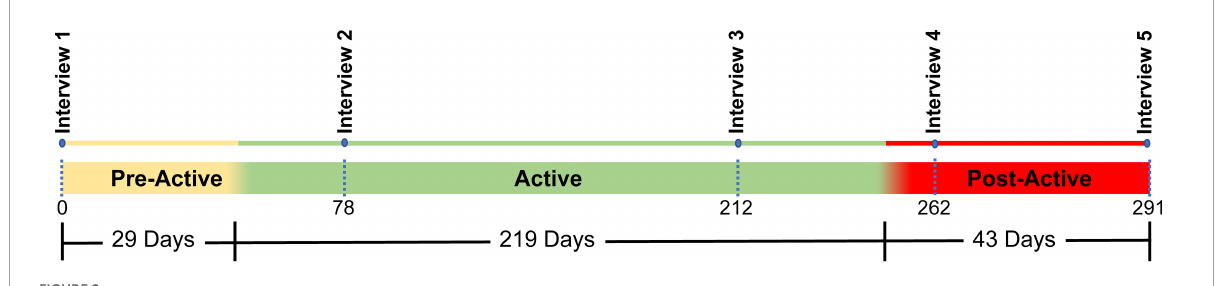
FIGURE2 Study timeline. The total study covered a period of 291 days and was divided into three sections: Pre-active (29 days), Active (219 days), and Post-Active (43 days). Five interviews (denoted by blue dots) were conducted over the course of the study. One interview occurred at the beginning of the trial, two interviews occurred during the active phase, and two occurred during the post active